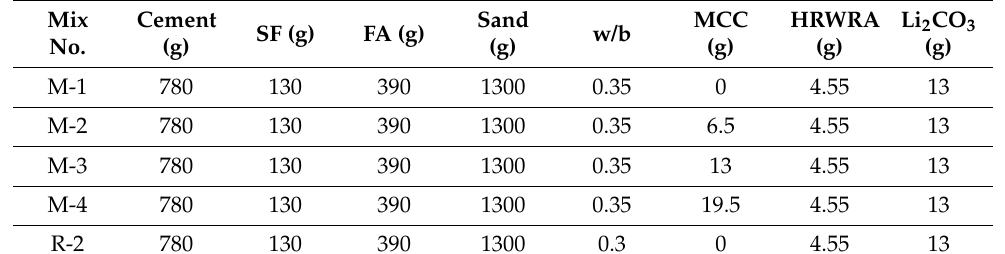
in Figure 5. Table 1. Mix proportions of the cement mortars used in this study. Adapted with permission from ref. [30]. Copyright 2019 Elsevier Ltd. Table 1. Mix proportions of the cement mortars used in this study, [30].